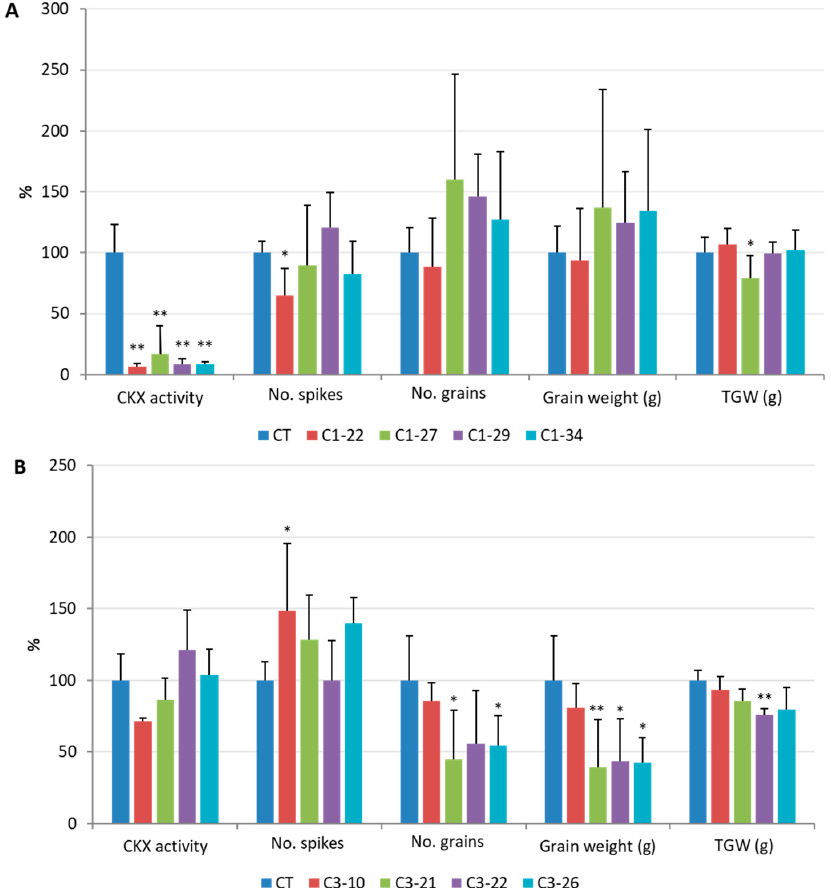
Figure 9. Comparison of enzymatic CKX activity and select yield parameters of seven DAP spikes of ckx1 ( A ) and ckx3 ( B ) mutant lines. The data are presented as the percentage of the values in control plants (CT), which were set to 100%, the actual values are shown in Tables S10 and S11. The yield parameters were measured for three biological replicates, which were significantly different from the control at * p < 0.05, ** p < 0.01.